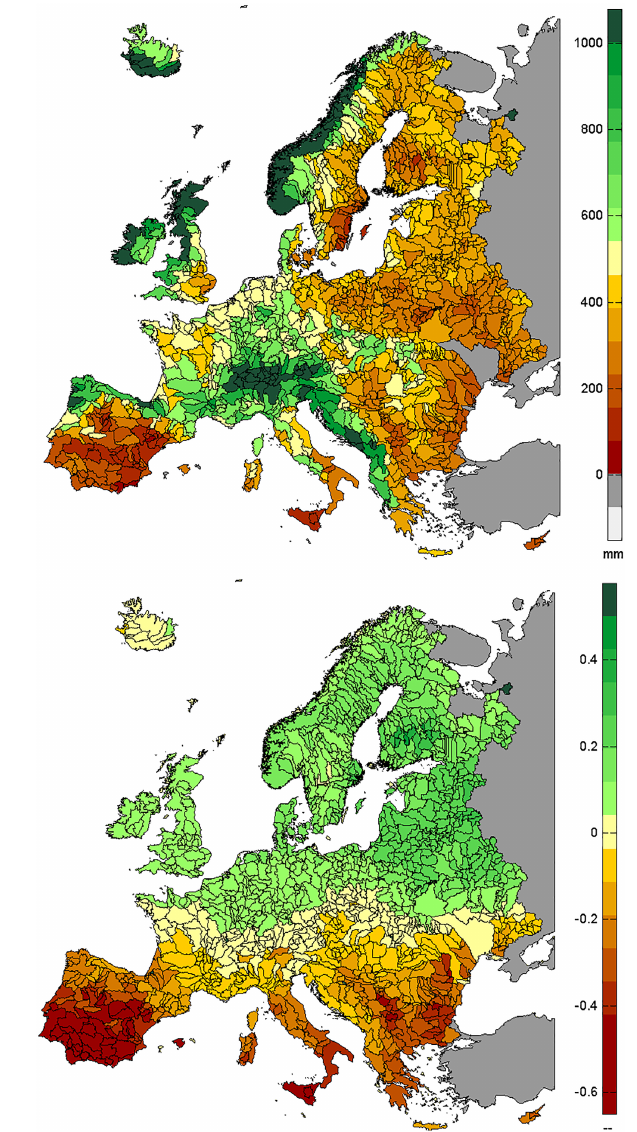
Figure 1. Subbasin average runoff (in mm) in the control pe- riod (1960–1999) and relative changes in the long term period (2060–2099) under emission scenario RCP4.5 according to PCR- GLOBWB model forced with GFDL climate data.